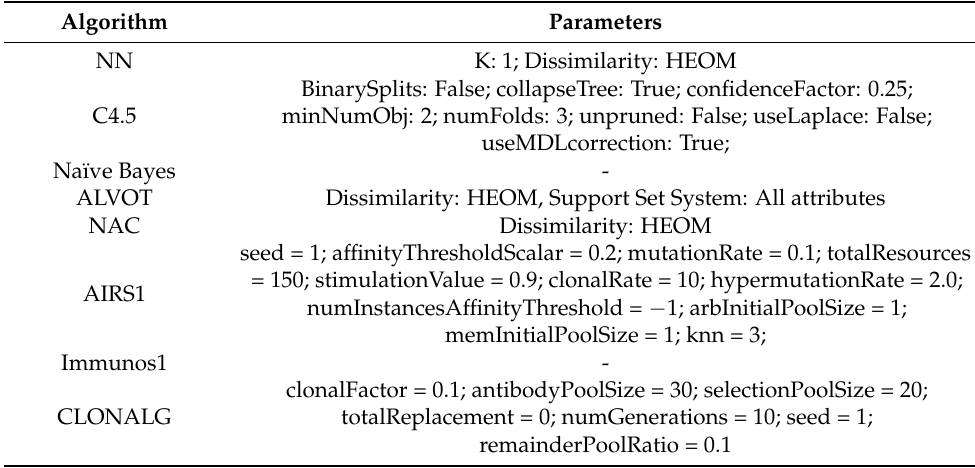
Table 2. Parameters of the algorithms.